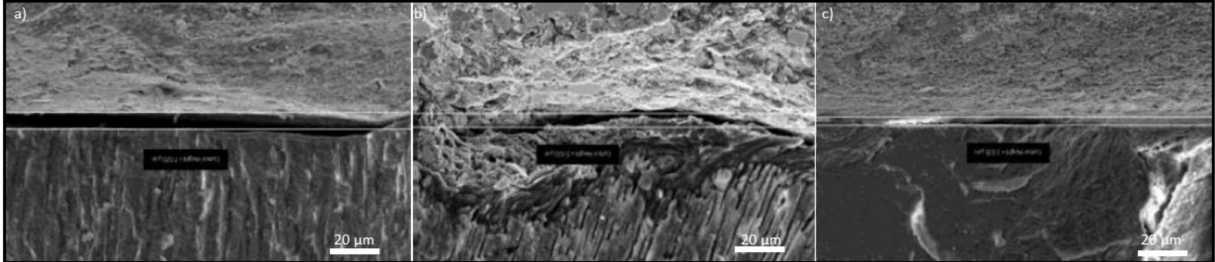
Figure 27. Leaks on the border of the root canal sealant and dentin after resilon obturation by thermoplastic condensation using the THC technique with measurements of the width of the gaps equal to (SEM): ( a ) 7.070 µ m; ( b ) 5.833 µ m; ( c ) 3.535 µ